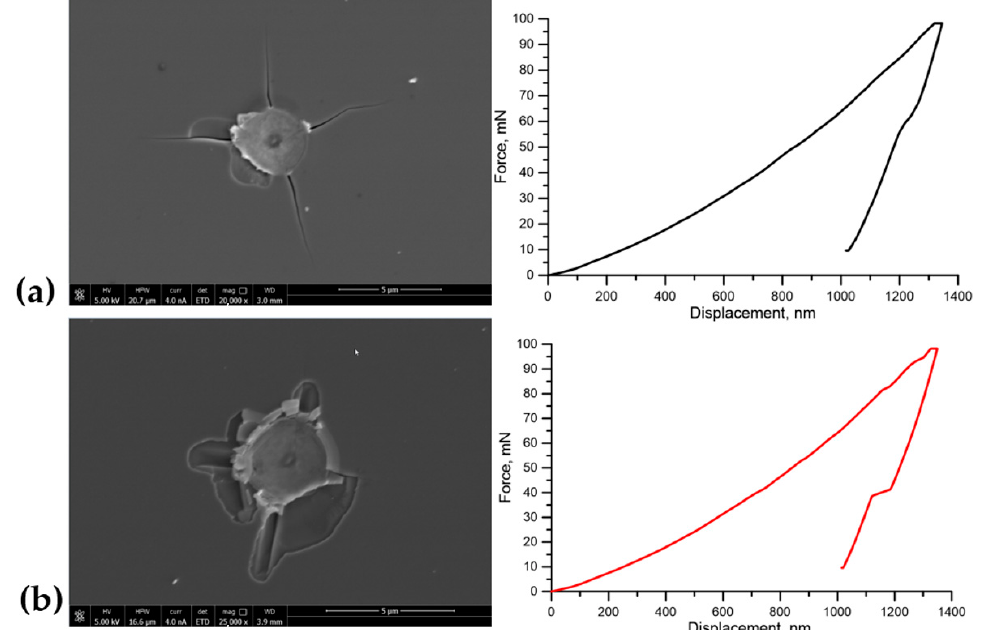
Figure 14. SEM images (Quanta 3D 200i, FEI, Hillsboro, OR, USA) revealing fractures in the ( a ) Si substrate and ( b ) TiN thin film after nanoindentation test with force–displacement curves received during test.